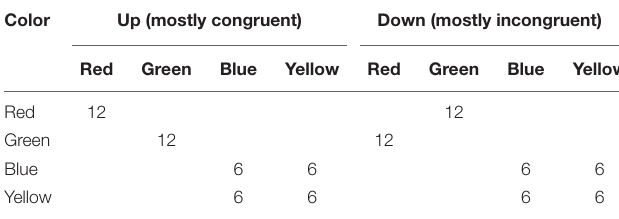
TABLE 2 | Context-specific proportion congruent design with inducer and diagnostic items.